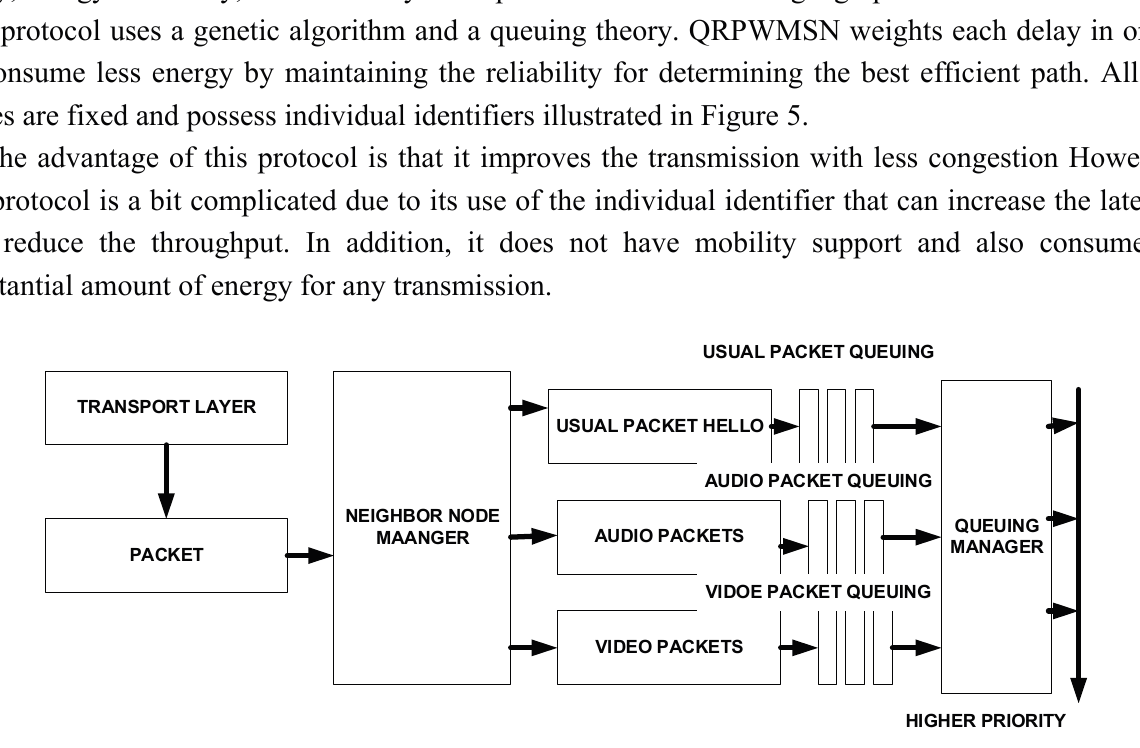
Figure 5. Queuing theory for proposed algorithm